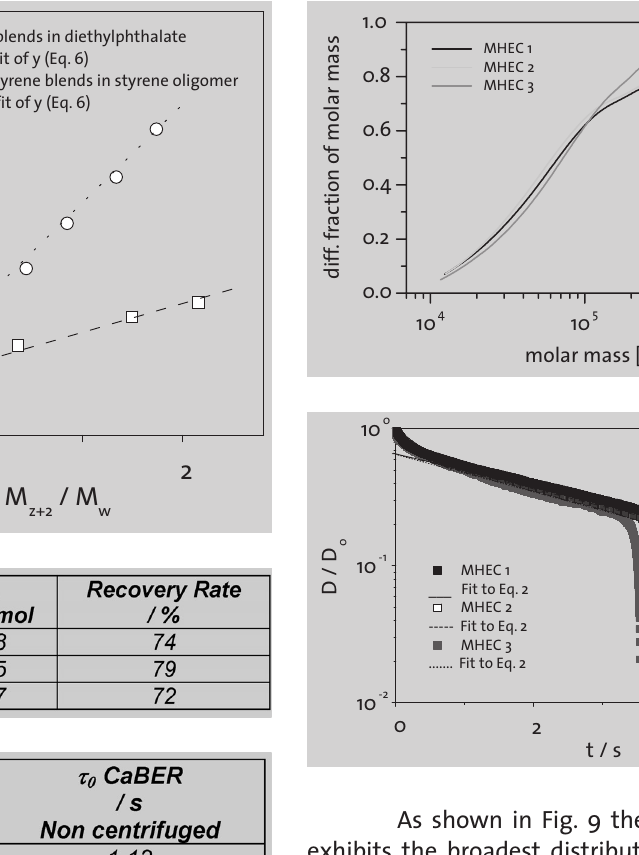
Figure 8 (left above): Least square fit of para- meters c and y to M z+2 /M w for polystyrene blends in diethylphthalate and binary polystyrene blends in styrene oligomer. Figure 9 (right above): Differential molecular weight distributions (MWD) of the investigated MHECs 1-3. Figure 10 (right middle): Filament diameter versus time for the centrifuged MHECs 1-3 at 25°C. Table 6 (left middle): Molecular parameters of investigated MHECs 1-3, determined via combined methods of SEC/MALLS/DRI. Table 7 (left below): Longest relaxation times of uniaxial elongation for the investigated centrifuged and non-centrifuged MHECs